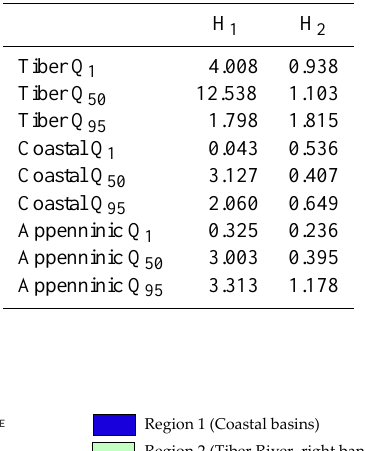
Table 5. Results of the Hosking and Wallis (1997) homogeneity tests for Q 1 , mean values Q 50 and annual minima Q 95 for the three regions initially identified.